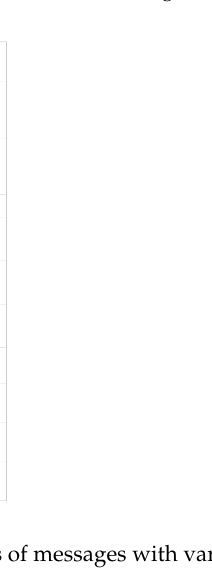
Figure 8. Sentiment of the actors’ digital footprints.